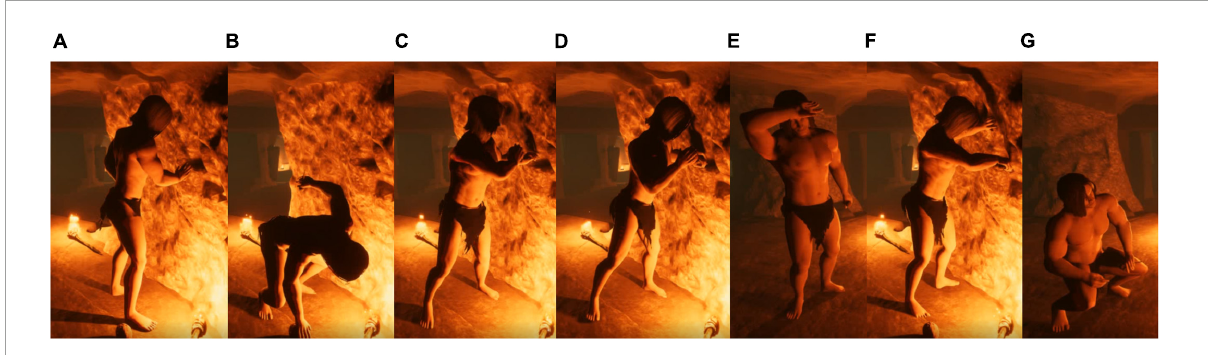
FIGURE3 Character animation sequence: (A) brushing, (B) picking up tool, (C,D) digging, (E) wiping sweat off brow, (F) screwing, and (G)